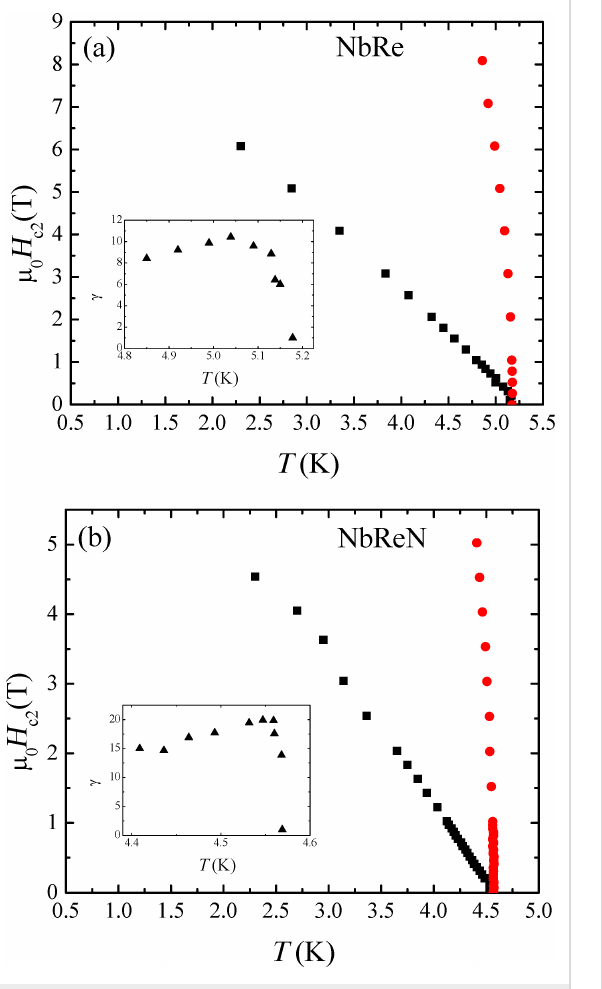
Figure 3: (a, b) H – T phase diagram of (a) the NbRe and (b) the NbReN microstrip. Black squares and red circles indicate the tempera- ture dependence of H c2 ⟂ and H c2 ∥ , respectively. The insets show the behavior of the anisotropy coefficient γ as a function of the tempera- ture.